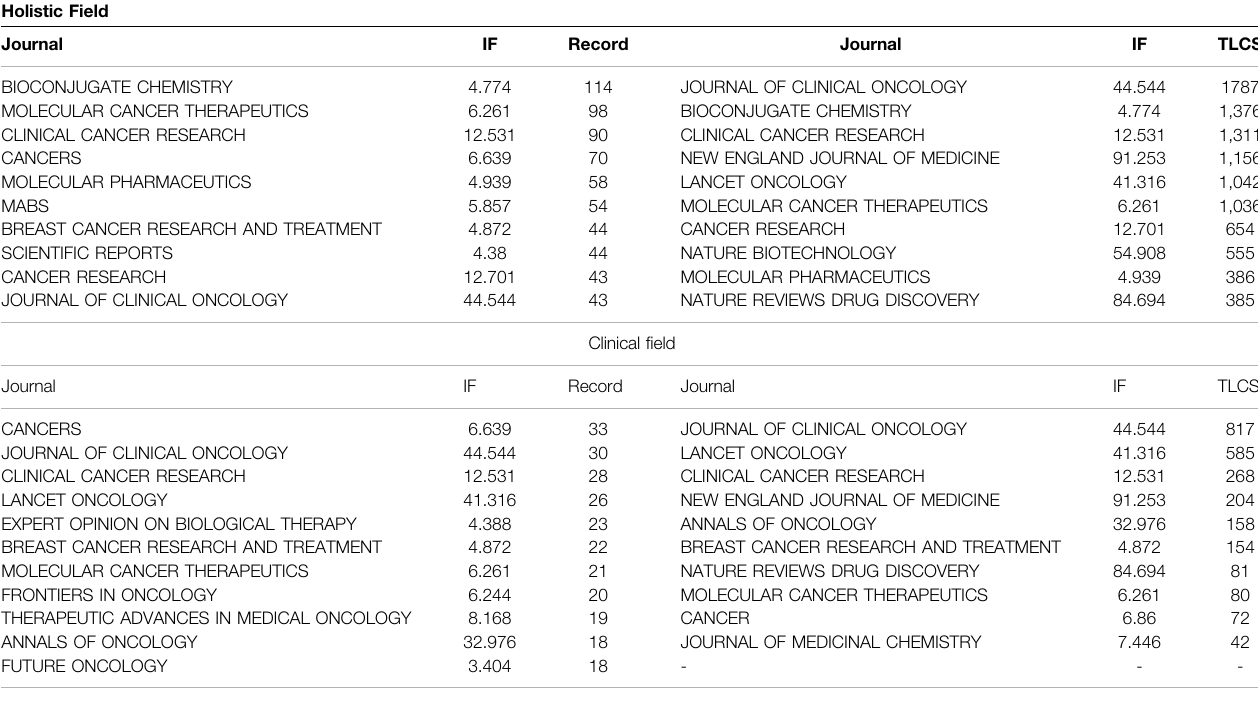
TABLE 3 | The top 10 journals and cited journals of ADC research in the solid cancer fi eld. Holistic Field